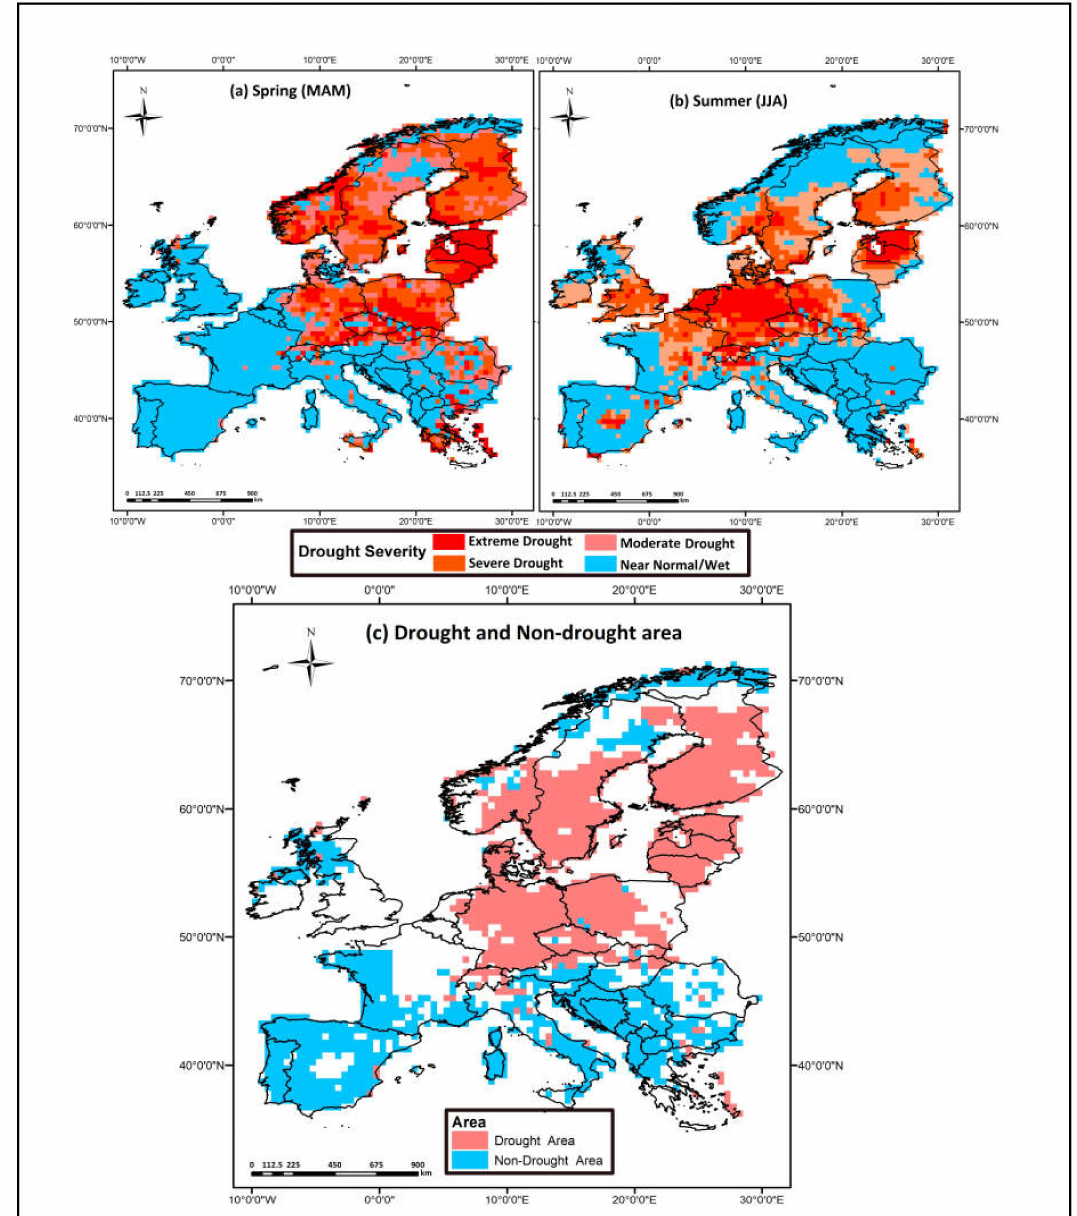
Figure 1. Drought severity map of Europe in ( a ) spring (SPEI-3 of May) and ( b ) summer (SPEI-3 of August) of 2018. The map is based on the Standardized Precipitation Evapotranspiration Index (SPEI) Global Drought Monitor (http: // spei.csic.es / index.html). ( c ) Drought area and non-drought area used in the study. Drought area has 2018 spring and summer SPEI values less than − 1. Non-drought area has 2018 spring and summer SPEI values greater than −